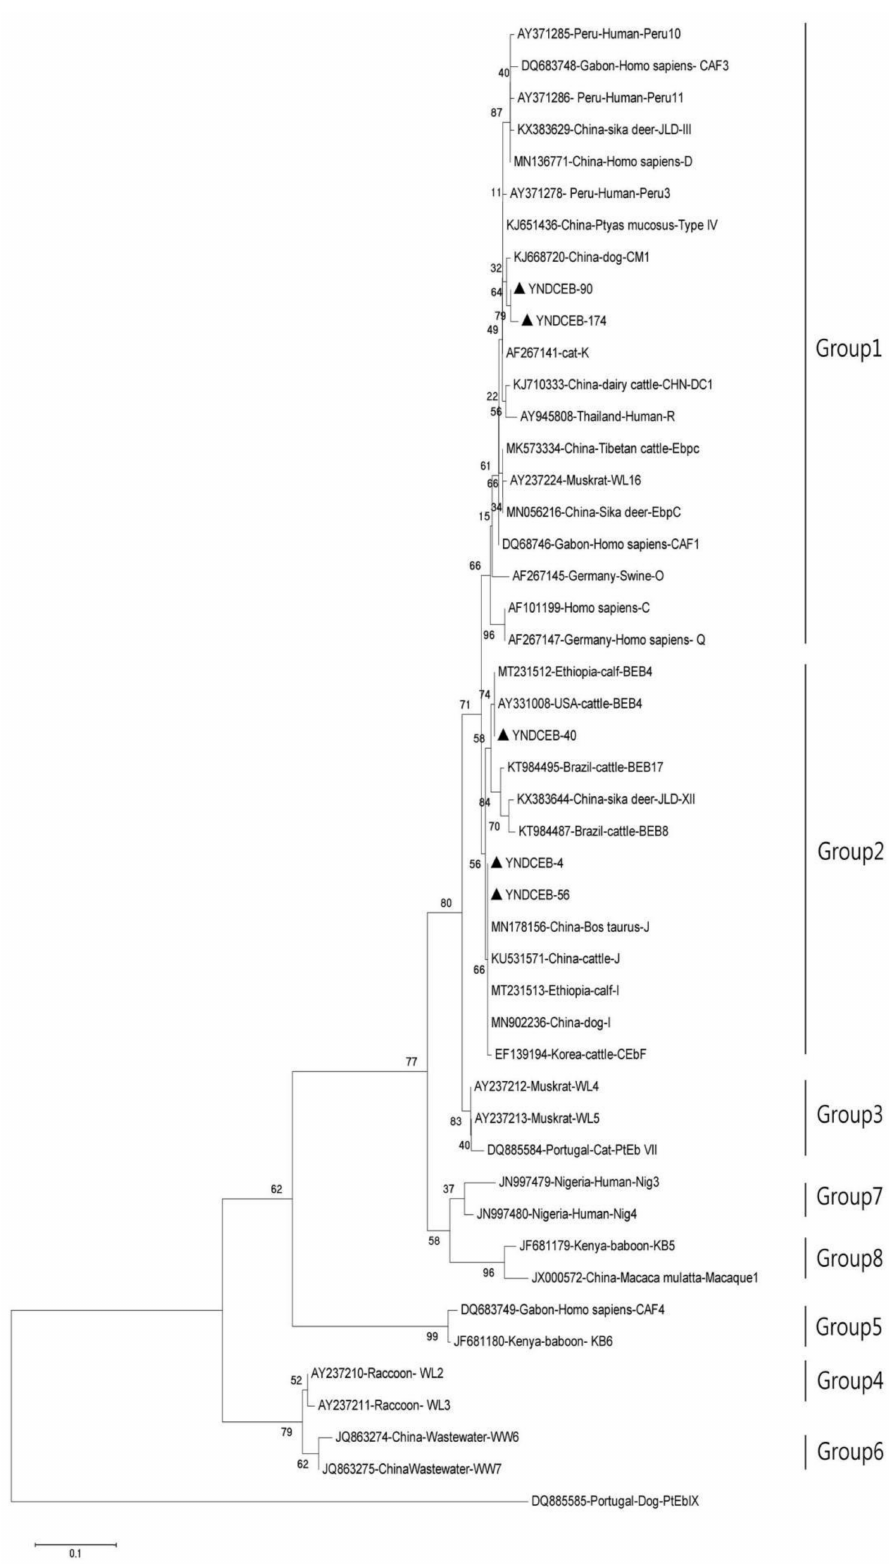
Figure 2. Phylogenetic relationships among Enterocytozoon bieneusi genotypes identified in this study and others already deposited in GenBank. Bootstrap values of >60% for 1000 replicates are shown on nodes. The known genotypes that were found around the world and the genotypes that were identified in this study are indicated with open and filled triangles,